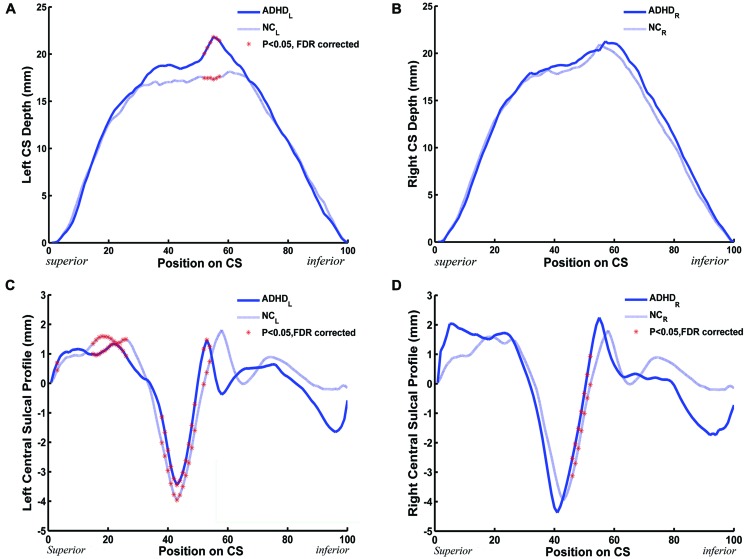
The between-group (ADHD vs. NC) difference along the mean DPPs and the central sulcal profile curve. (A,B) The mean DPP across the children with ADHD (blue solid trace) and the mean DPP across the healthy children (blue dashed trace) were plotted by position. (C,D) The average central sulcal profile of the children with ADHD (blue solid trace) and the average central sulcal profile of the healthy children (blue dashed trace) were plotted by position. The red stars represent the positions on the CS where the depth (left: 52 ≤ y ≤ 57; right: none) or the sulcal profile (left: y = 3,15 ≤ y ≤ 26, 38 ≤ y ≤ 49, 52 ≤ y ≤ 54; right: 46 ≤ y ≤ 52) of the CSs for the children with ADHD were significantly [∗Ps < 0.05 after false discovery rate (FDR) correction] different from those of the healthy children.